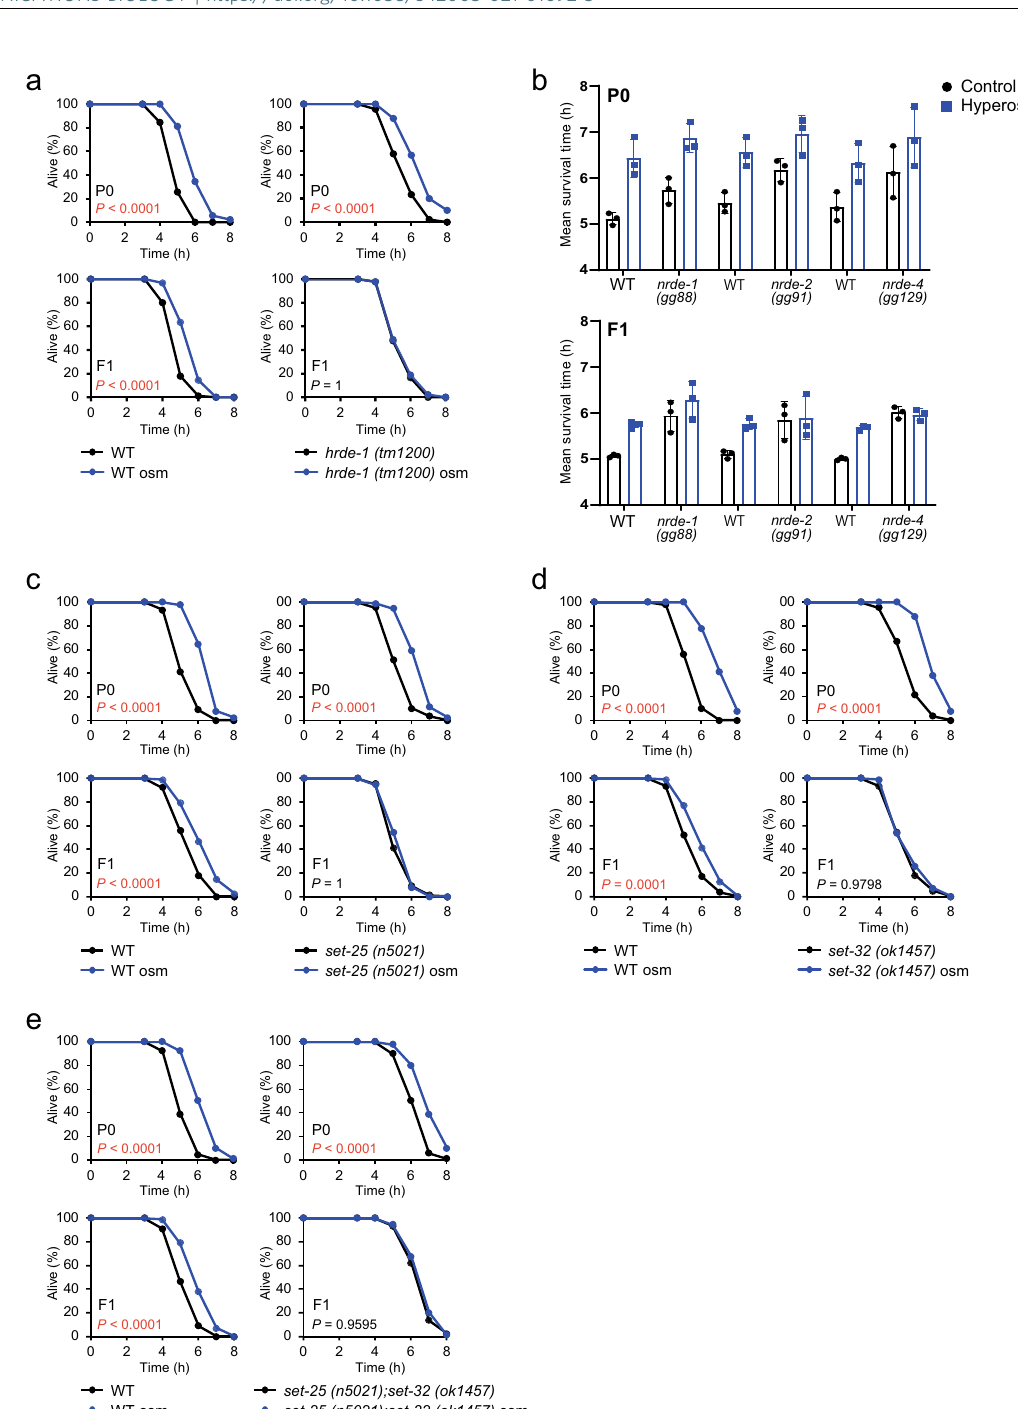
Fig. 2 Components in the germline nuclear RNAi pathway are required for the inheritance of hormesis effect. a Oxidative stress resistance (1.8 mM H 2 O 2 ) of WT (left) and hrde-1 mutants (right) in the P0 generation (upper) and the F1 generation (lower). b The mean survival time to oxidative stress of three independent experiments is shown. Error bars, S.D. c Oxidative stress resistance of WT (left) and set-25 mutants (right) in the P0 generation (upper) and the F1 generation (lower). d Oxidative stress resistance of WT (left) and set-32 mutants (right) in the P0 generation (upper) and the F1 generation (lower). e Oxidative stress resistance of WT (left) and set-25;set-32 double-mutants (right) in the P0 generation (upper) and the F1 generation (lower). Three independent experiments are integrated into each survival curve ( n = 90). Mean survival time and statistics are presented in Supplementary Data 1. P values were calculated by log-rank test with Bonferroni